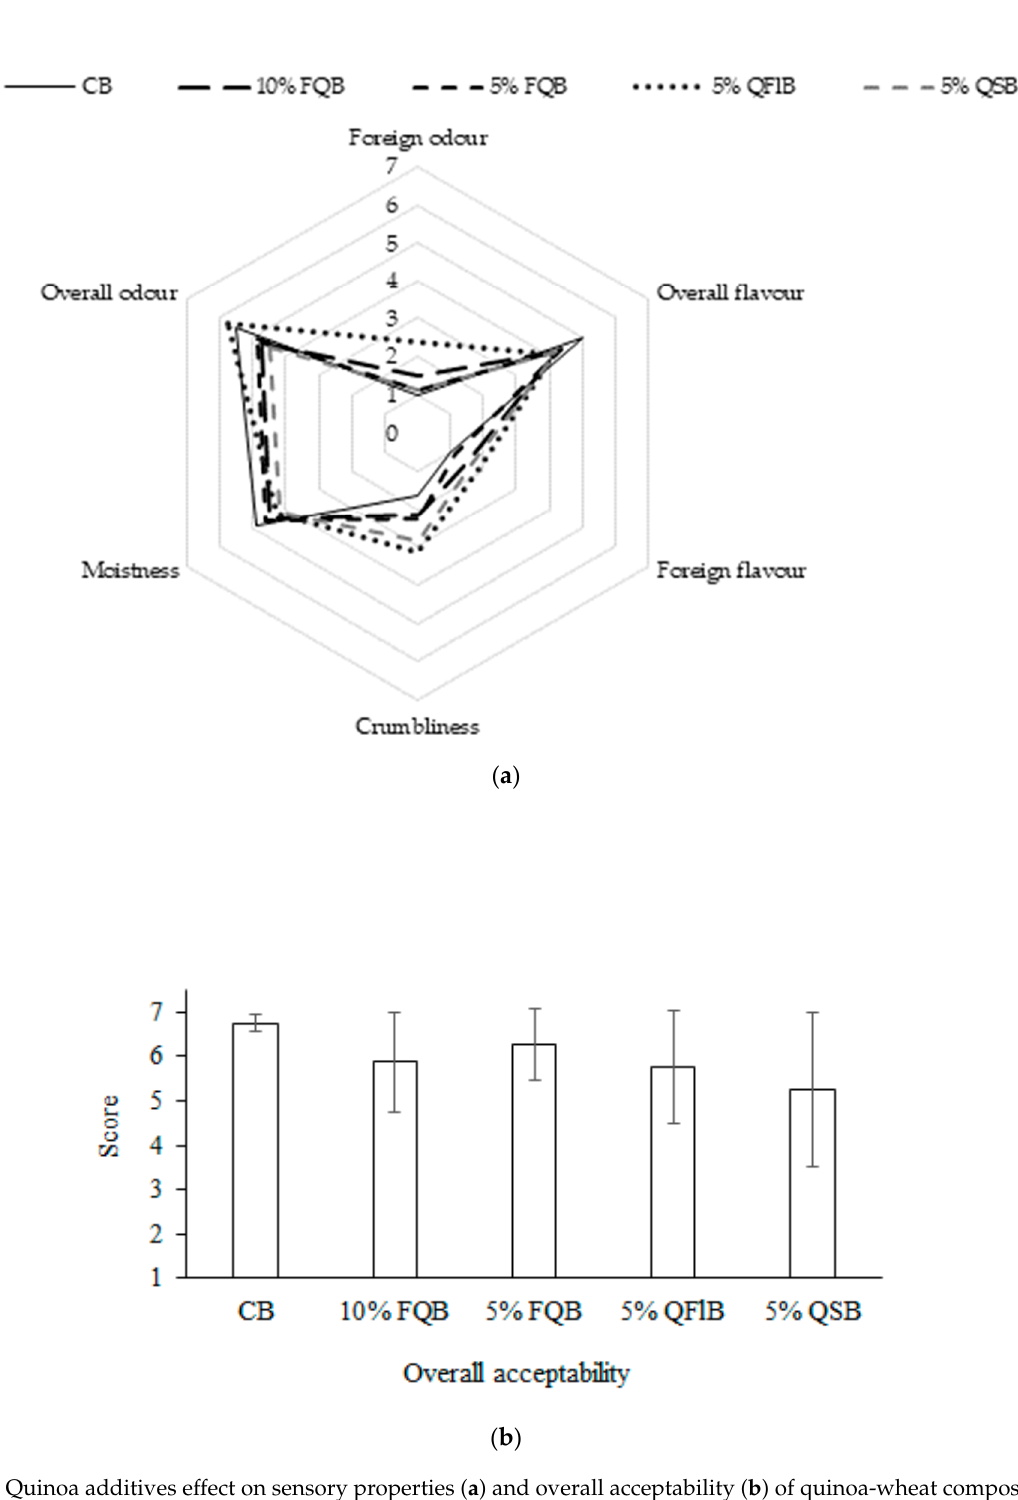
Figure 2. Quinoa additives effect on sensory properties ( a ) and overall acceptability ( b ) of quinoa-wheat composite bread.